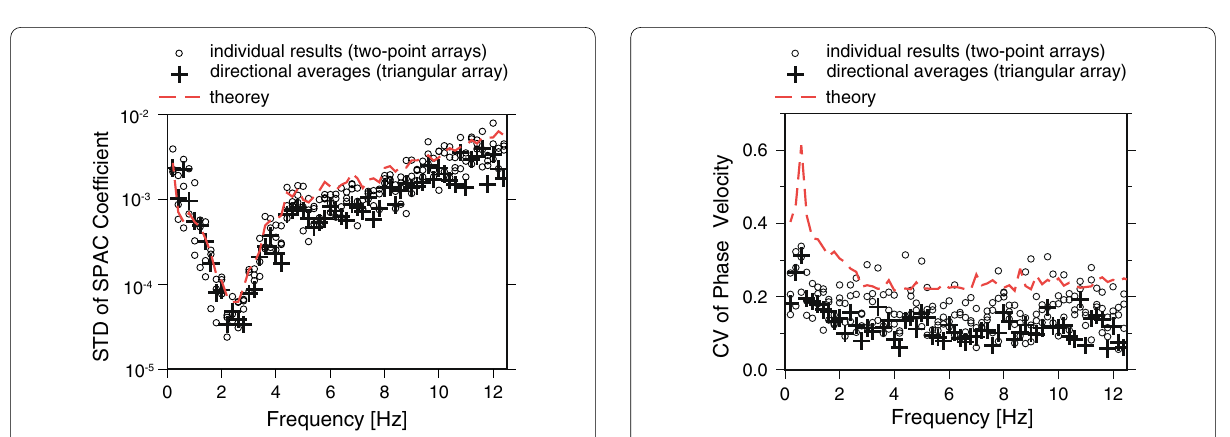
Fig. 6 Standard deviations normalized by the average values (coefficient of variation, CV) of the phase velocities for an array with a radius of 0.58 m. Individual analysis results (two-point arrays, circles) and average results (triangular array, crosses) are plotted. The theoretical calculation results (red broken line) are also plotted for